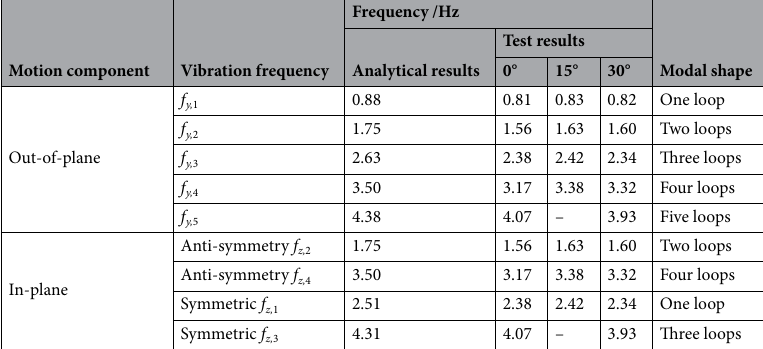
Table 3. Modal frequency based on the measurement of point D 2 .